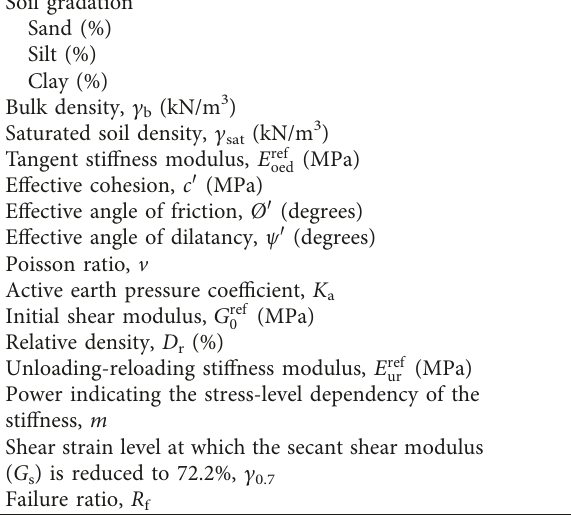
Table 3: Overview of the soil parameters used for tunnel sequences (Schotte et al. [24]). Soil